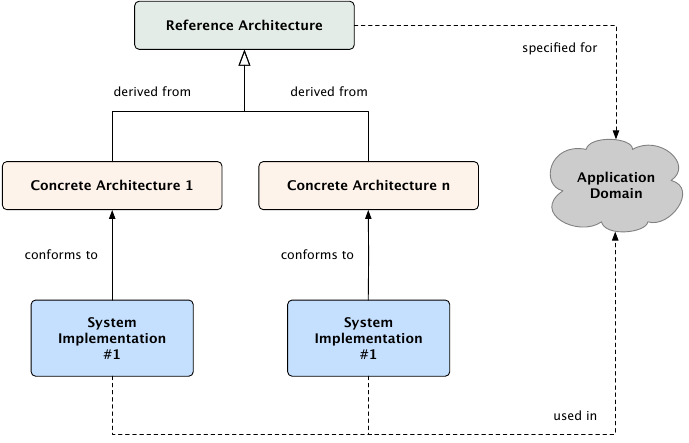
Figure 2. Reference architecture, concrete architectures, and systems